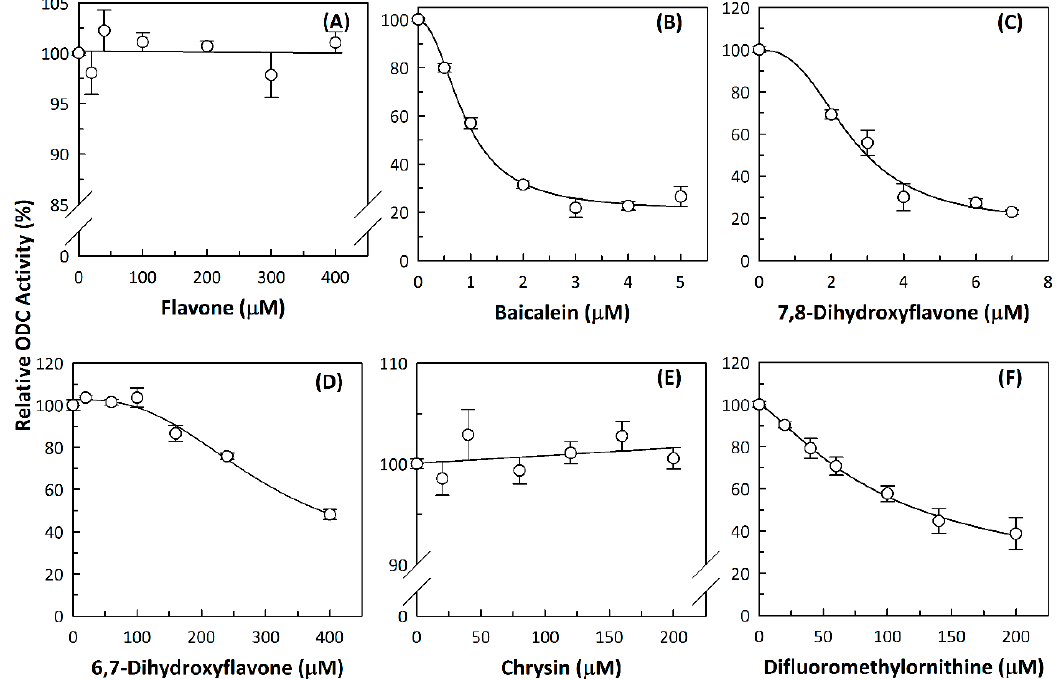
Figure 1. Dose-dependent inhibition of flavone derivatives toward the ornithine decarboxylase (ODC) enzyme . ( A ) Flavone; ( B ) baicalein; ( C ) 7,8-Dihydroxyflavone (7,8-DHF); ( D ) 6,7-Dihydroxyflavone (6,7-DHF); ( E ) chrysin; ( F ) difluoromethylornithine (DFMO), an irreversible inhibitor of ODC. Enzyme activity of ODC were measured with a series of concentrations of the respective flavone derivatives ( n = 3). Table 1. Flavonoids with A ring substitution(s) and with the the half maximal inhibitory concentration (IC 50 ) to ornithine decarboxylase (ODC).